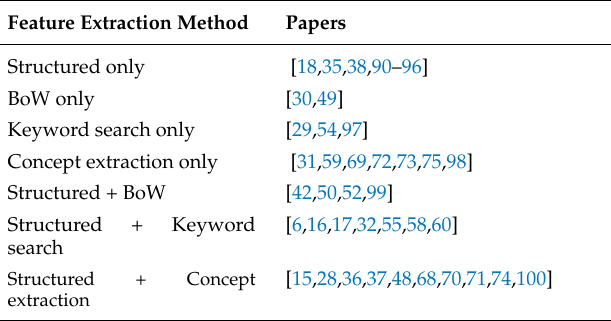
Table 2. Categorise of feature extraction